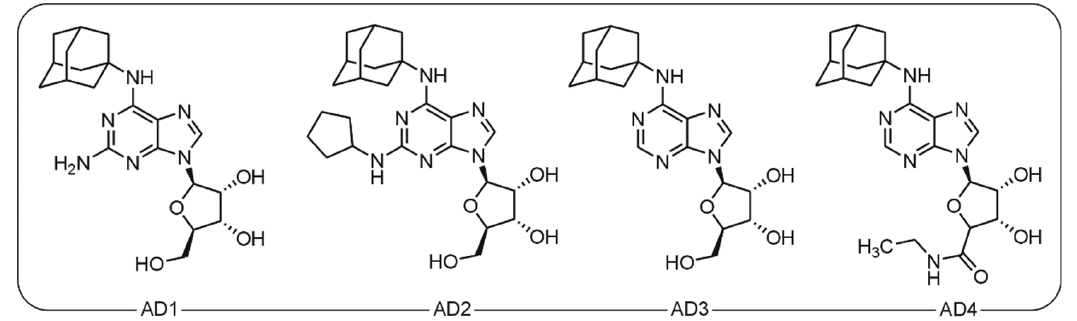
Figure 1. Previously published adamantane-based purine nucleosides.